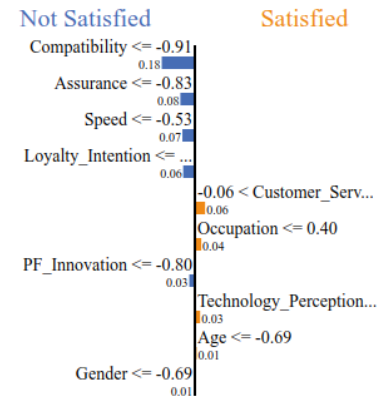
Figure 3. SVM— Interpretation with